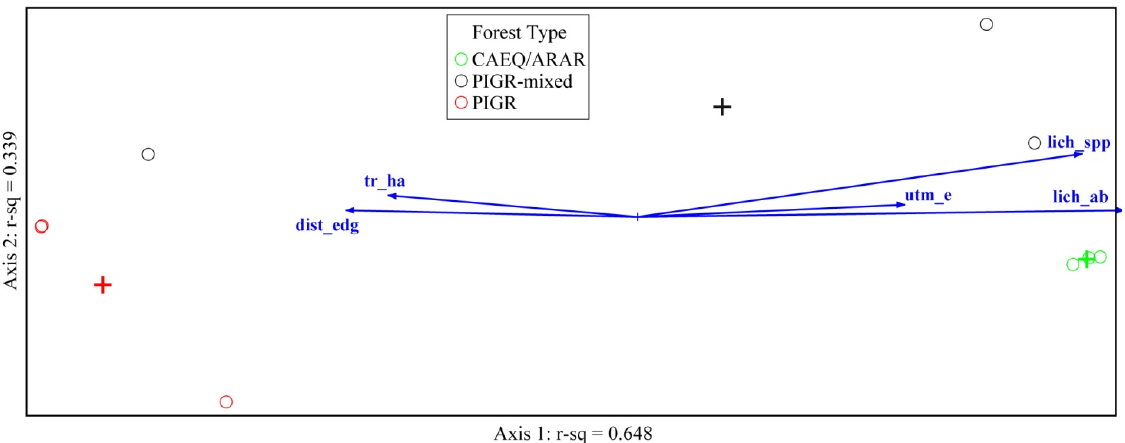
Figure 2. A jointplot depicts the results of nonmetric multidimensional scaling (NMS) ordination of eight lichen species by nine sample plots. Highly correlated environmental variables ( r > 0.5 or < − 0.5; Table 4) are overlaid on the ordination to show relationships to primary axes. Vectors indicate direction (arrow) and strength (length) of these factors in the ordination space defined by plot values of all measured variables. Variables shown are: distance from the sample plot center to forest/beach edge (dist_edg), total trees per ha (tr_ha), lichen species count per plot (lich_spp), UTM location easting (utm_e), and abundance of all lichen species per plot (lich_ab). Forest types are described in Table 1 (CAEQ/ARAR = Casuarina equisetifolia / Argusia argentea ) and show how groups separate in the Heron Island lichen ordination space. Symbols in bold correspond to forest type group centroid values.